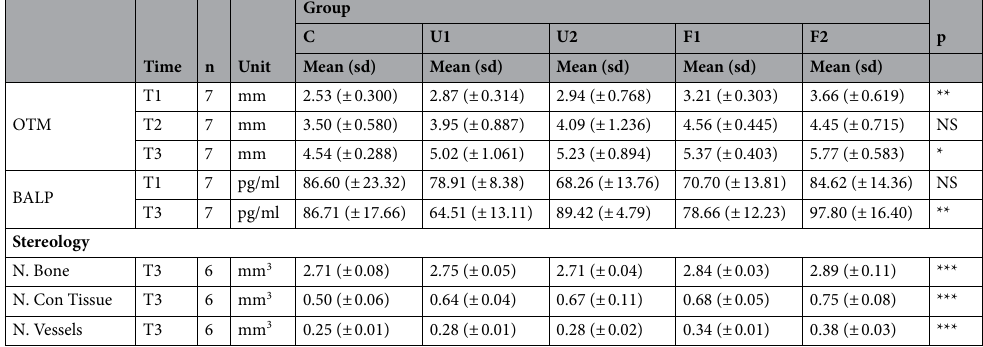
Table 1. Summary of OTM, BALP, and SVE results. U1 = unfocused/500 impulses, U2 = unfocused/1000 impulses, F1 = focused/500 impulses, F2 = focused/1000 impulses, and C = control groups. T1 = 7th day, T2 = 14th day, and T3 = 21st day. *p < 0.05, **p < 0.01, ***p < 0.001.